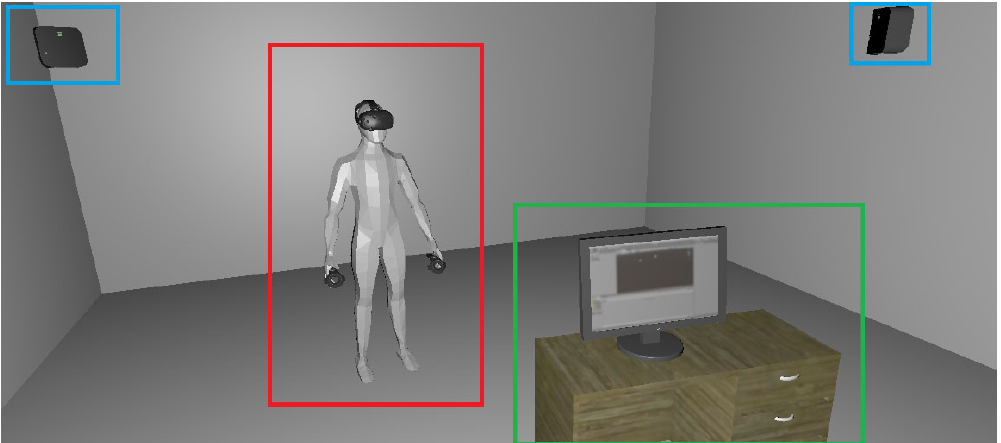
Figure 1. The architecture of the proposed tool. The red box highlights the patient wearing the Head-Mounted Display (HMD) and the controllers, the green box highlights the therapist workstation and, finally, the blue boxes highlight the two base stations.